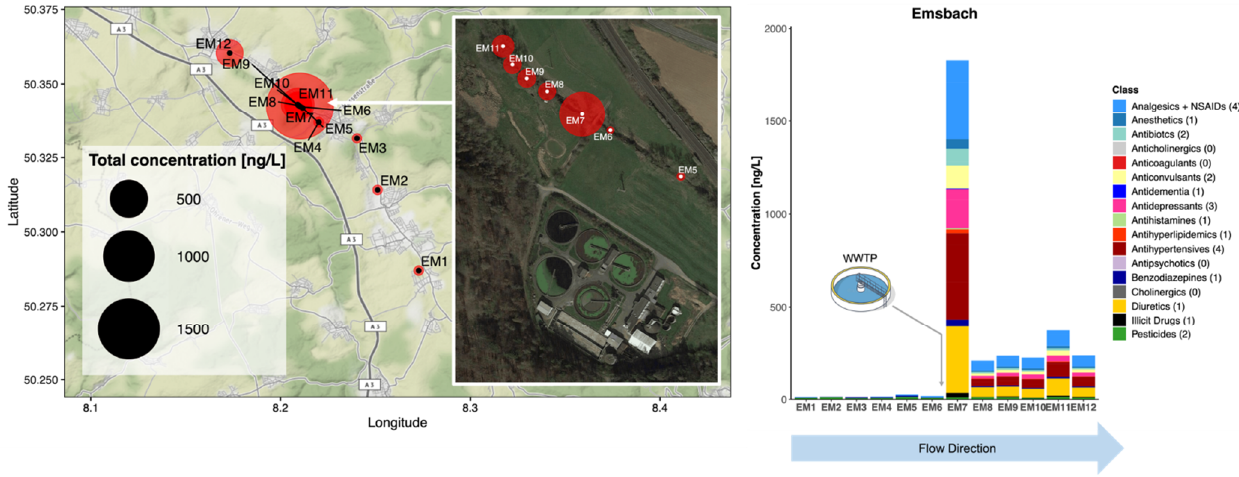
Figure 3. Occurrence of all CECs monitored in the River Emsbach (SZ) in the Limburg-Weilburg district, Hesse, Germany, in grab samples taken in 2020. Red circles represent sampling points (labelled EM1-12) and the size of the circle represents the combined total CEC concentration in ng/L. Individual compounds within each class can be found in Table S8.